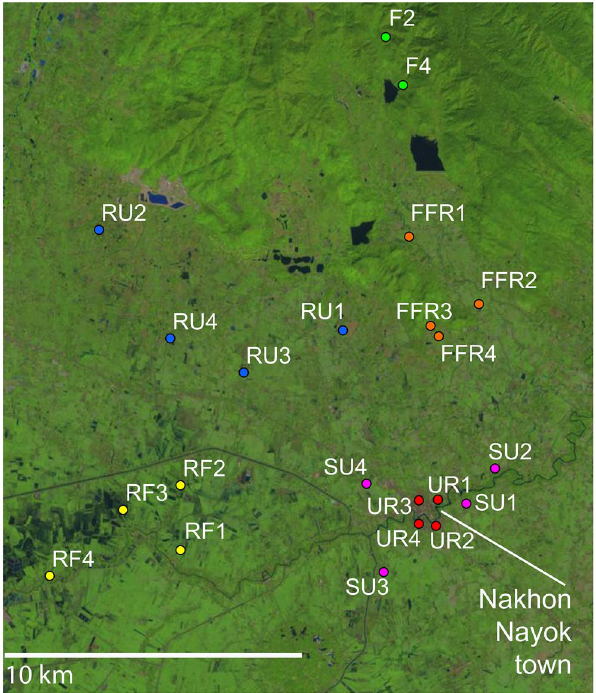
Figure 2. Map of study area in Nakhon Nayok Province, Thailand. Mosquitoes were collected in 24 sites representing six habitat types: Forest (F1 to F4), Fragmented Forest (FFR1 to FFR4), Rice Field (RF1 to RF4), Rural (RU1 to RU4), Suburban (SU1 to SU4), and Urban habitats (UR1 to UR2). Satellite imagery courtesy of the U.S. Geological Survey Land Remote Sensing Program (Landsat 8).